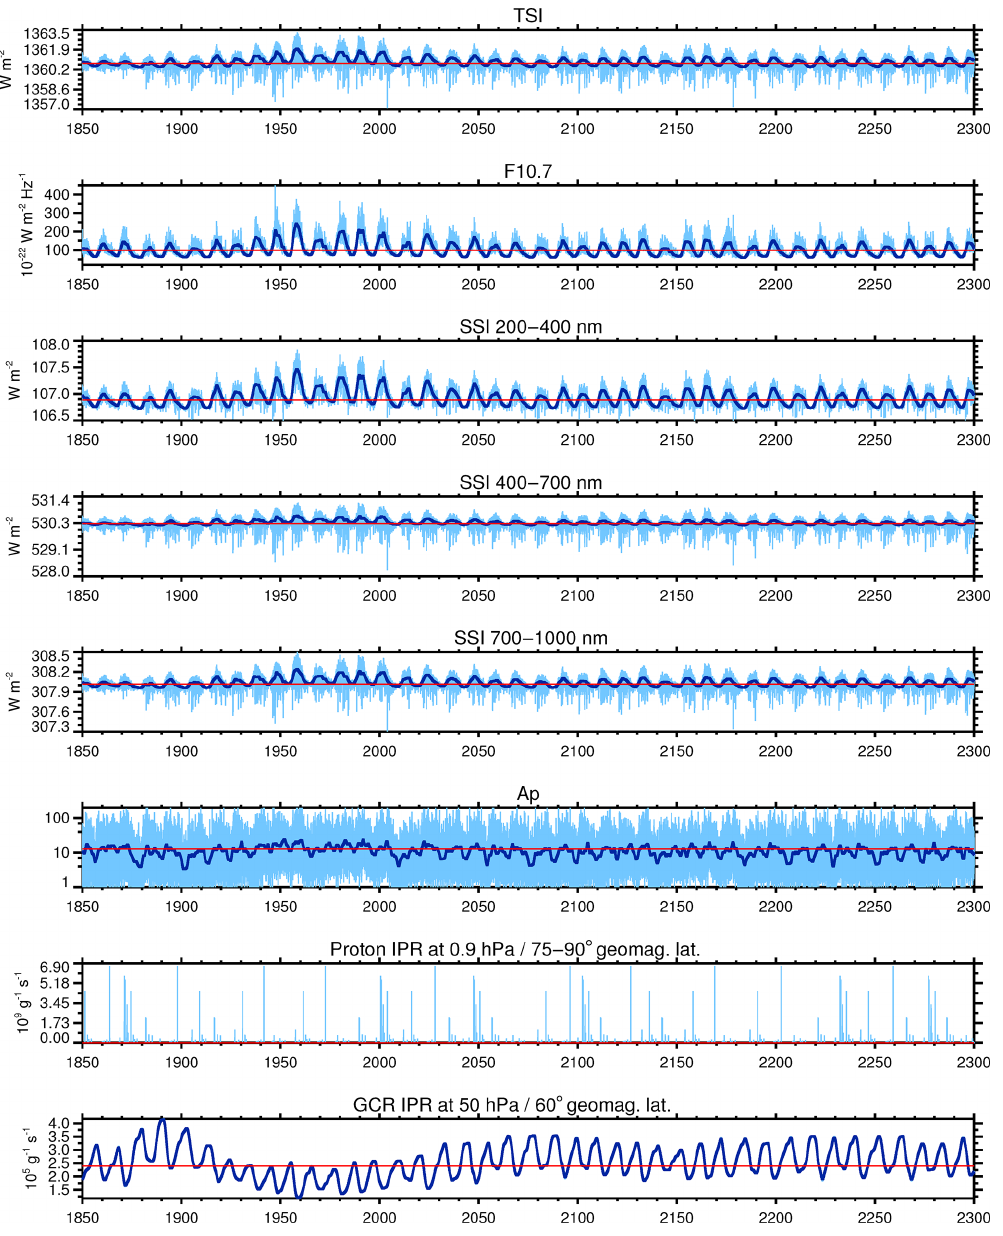
Figure 24. CMIP6 reference (REF) scenario forcing shown for (from top to bottom) TSI, F10.7, SSI at 200–400nm, SSI at 400–700nm, SSI at 700–1000nm, Ap, proton IPR at 1hPa and 70 ◦ geomagnetic latitude, and GCR IPR 50hPa and 60 ◦ geomagnetic latitude. Annually smoothed values are shown by dark blue lines. Constant values of the PI control forcing (see Sect. 4) are shown with red lines as